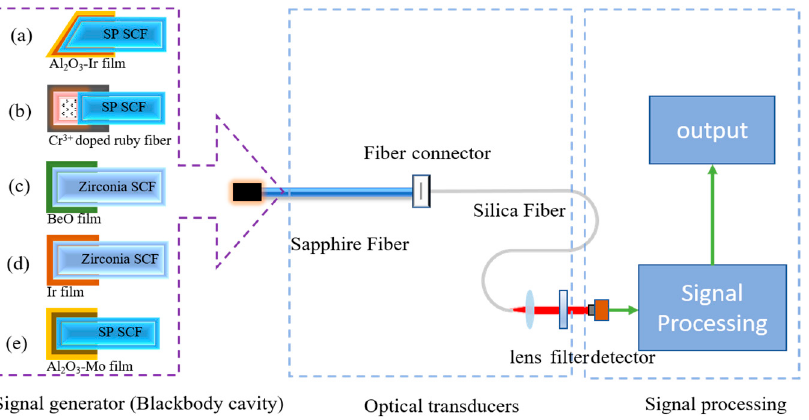
Figure 3. A schematic diagram for high-temperature blackbody optical fiber sensor system and various blackbody cavities made of ( a ) SP SCF + Al 2 O 3 -Ir; ( b ) SP SCF + Cr 3+ doped ruby fiber [30]; ( c ) Zirconia SCF + BeO; ( d ) Zirconia SCF + Ir; ( e ) SP SCF Al 2 O 3 -MO. SCF: single-crystal fiber.